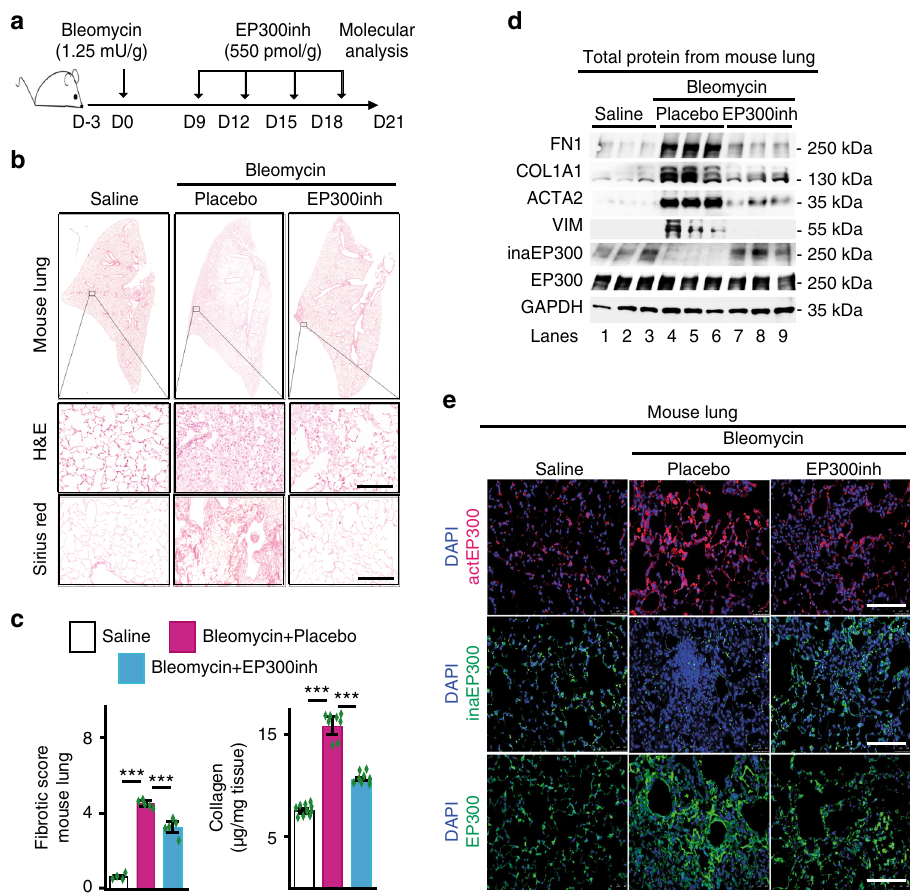
Fig. 7 EP300 inhibition counteracts fi brosis hallmarks in bleomycin mouse model. a Scheme shows experimental setup. Three group of mice (control group n = 4, experimental groups n = 5, in each group biologically independent animals) were orotracheally instilled with saline or bleomycin (1.25 mU per g body weight) at day 0 and subsequently orotracheally instilled with placebo (vehicle solution) or EP300 inhibitor (EP300inh, CBP30, 550 pmol per g body weight) on days 9, 12, 15, and 18. Mice were collected for analysis at day 21. b Top: representative histological analysis using hematoxylin and eosin (H&E) stain on left lung sections from mice treated as in a . Squares are shown below at higher magni fi cation. Bottom, representative light microscopy after Sirius red staining monitoring collagen deposition on left lung sections from mice treated as in a . Scale bar = 100 μ m. See Supplementary Fig. 8. c Left: fi brotic (Ashcroft) score quanti fi cation from representative Sirius red staining on left lung sections from mice treated as in a . Right, collagen content quanti fi cation by Sircol assay using lung homogenates from mice treated as in a . Data are shown as mean (SD) ( n = 10, 8, or 7 biologically independent samples); asterisks, P -values after unpaired t -test, two tailed, *** P < 0.001. Source data are provided as a Source Data fi le. d WB using the indicated antibodies and lung homogenates from three representative mice from each experimental group described in a . e Confocal microscopy after immunostaining using EP300, actP300, or inaEP300-speci fi c antibodies in lung sections from representative mice from each experimental group described in a . ActEP300, active EP300; inaEP300, inactive EP300. DAPI, nuclear staining. Scale bar, 500 µ